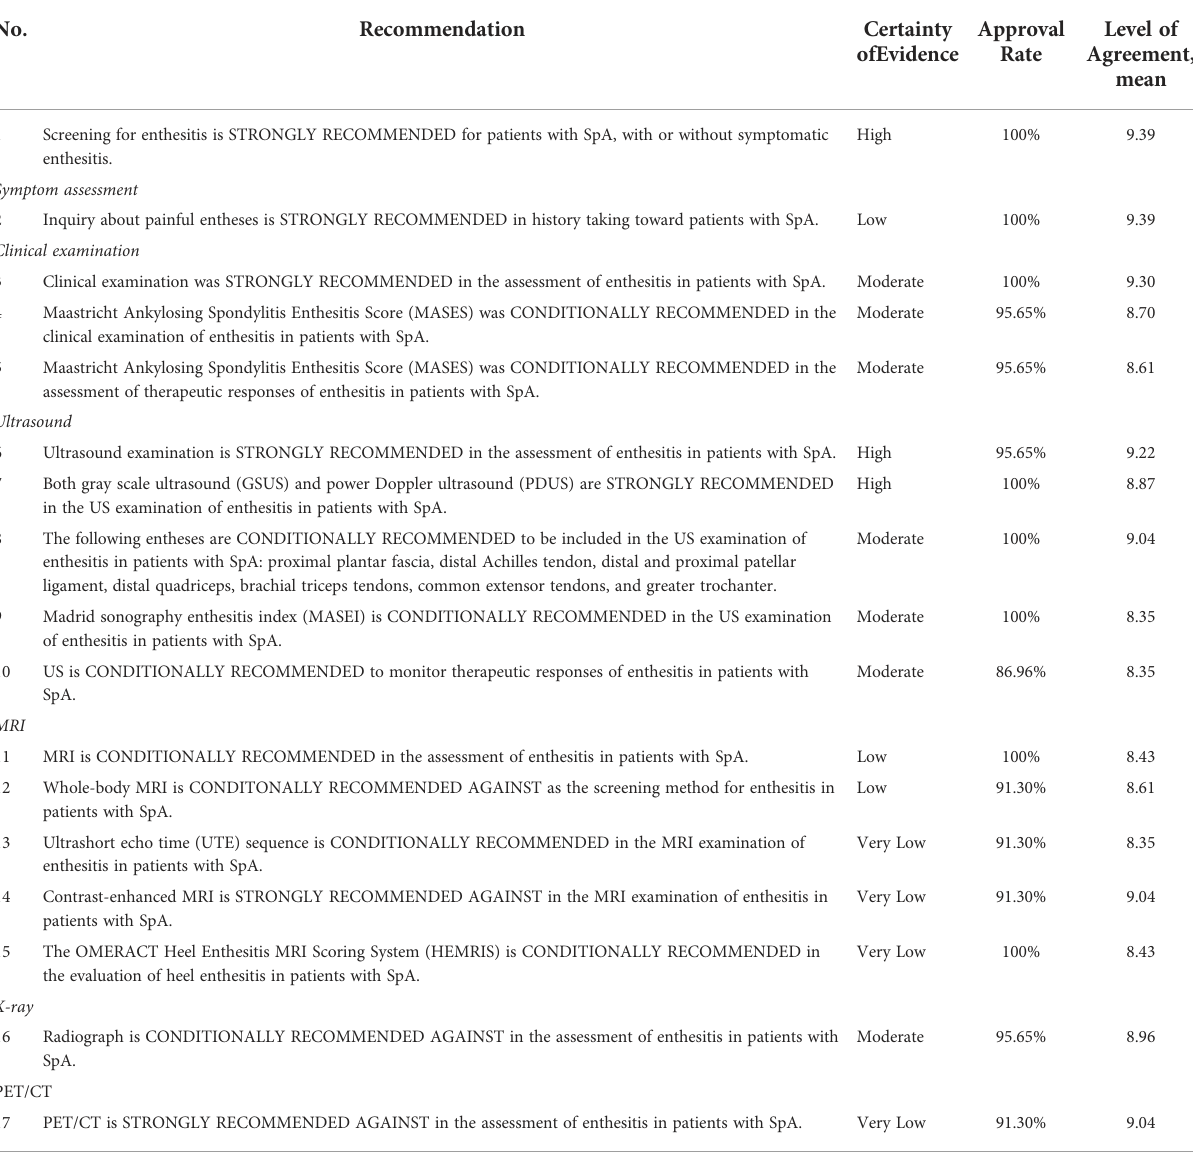
TABLE 1 Recommendations for approaches pertaining to the screening and evaluation of enthesitis in patients with SpA.